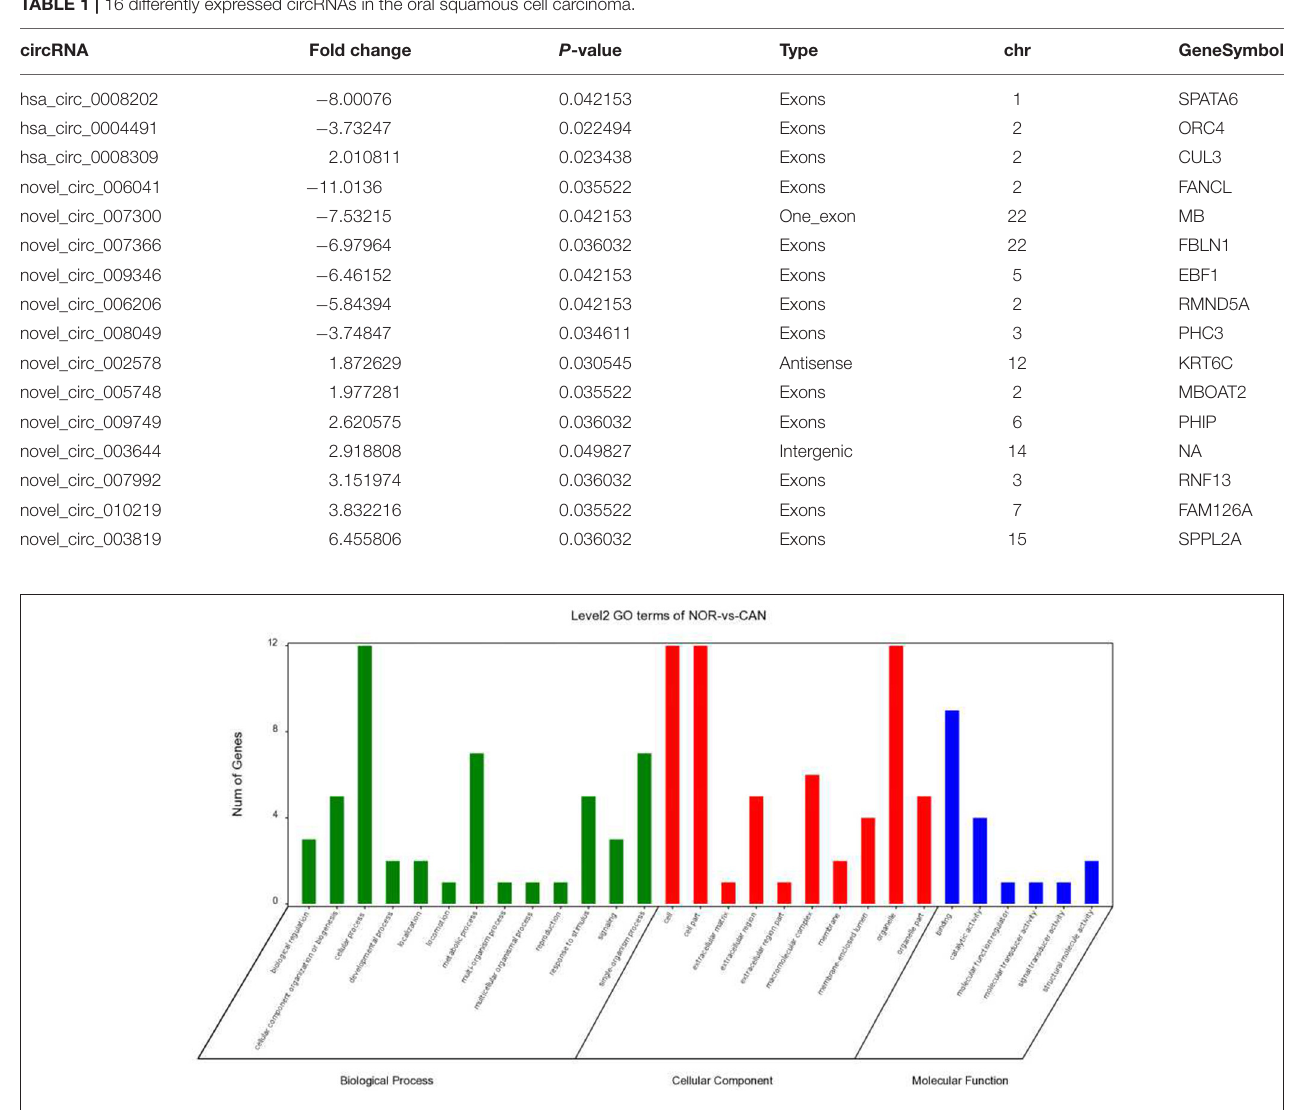
FIGURE 7 | GO enrichment analysis for circRNAs gene